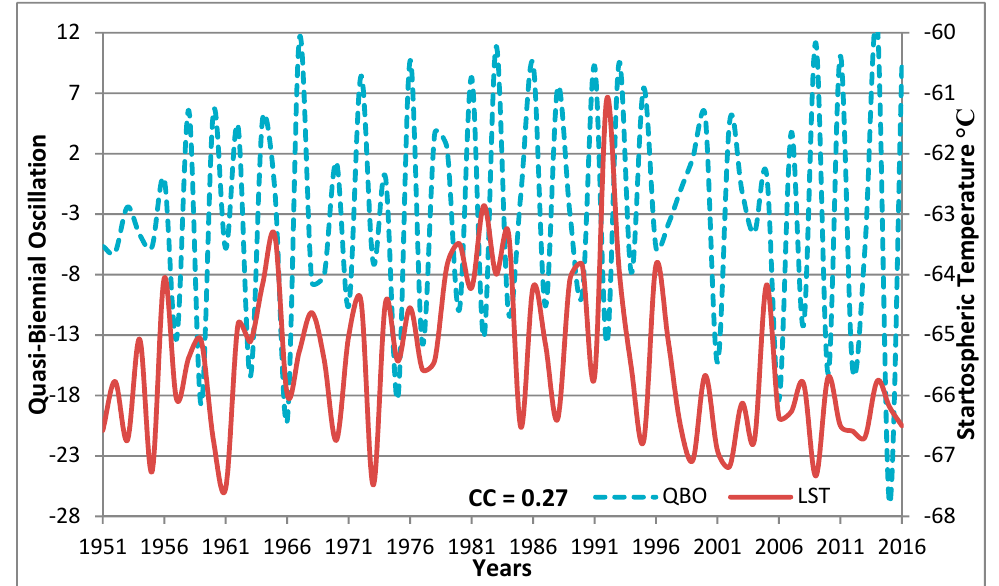
(solid curve), and a 95% confidence level (dashed curve).